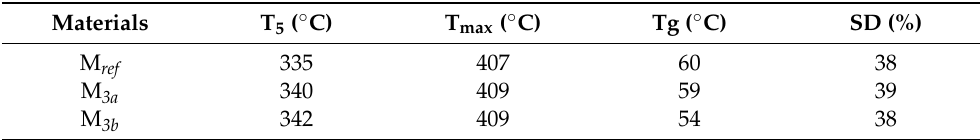
Table 1. Properties of membranes: T 5 and T max obtained from TGA, Tg obtained from DSC, swelling degree in water